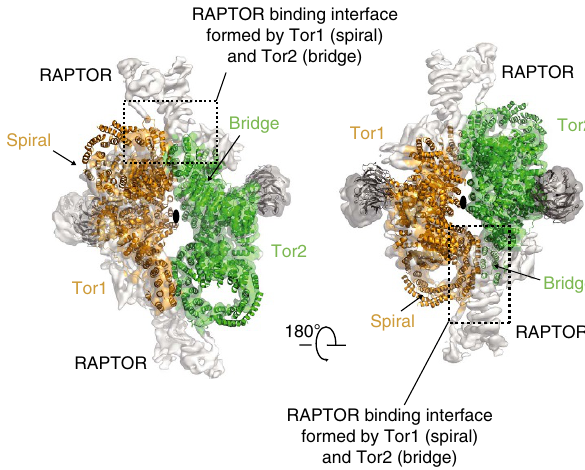
Figure 5 | RAPTOR in the mTORC1 complex engages both mTOR molecules. Each of the two KmTor–Lst8 heterodimers are uniformly colored and shown as ribbons superimposed on the cryo-EM density for mTORC1 (EMDB-3212). Our topology of Tor implies that the RAPTOR in the mTORC1 complex engages both mTOR molecules through interaction with the spiral of one mTOR and the bridge of the dimer-related mTOR (interface enclosed in the dotted